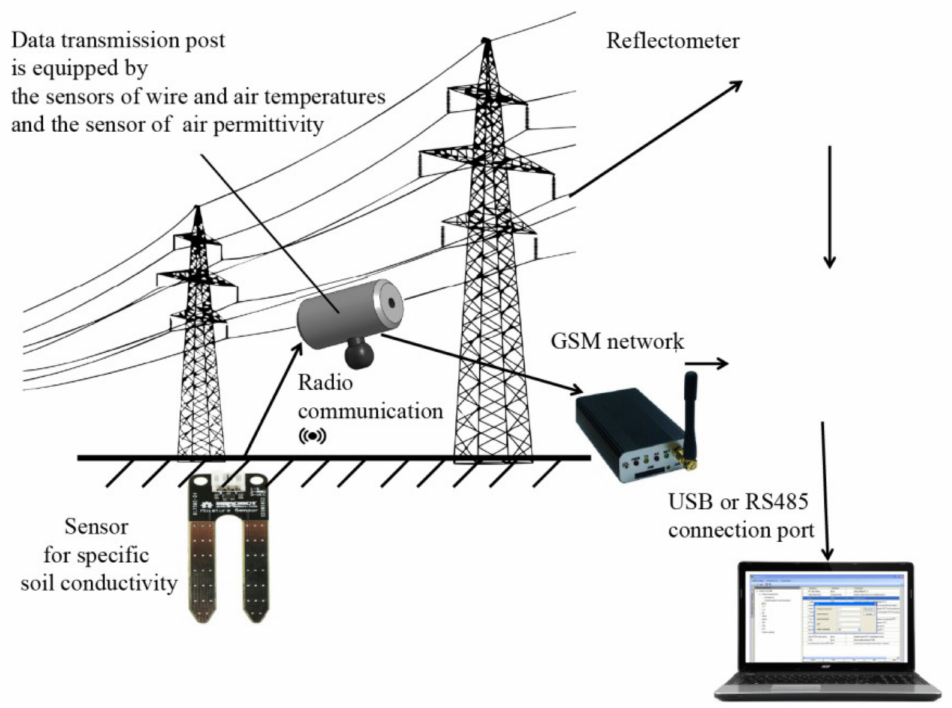
Figure 18. Principal scheme of an intelligent system of distance relay protection with adaptive algorithms for determine setpoints of the overhead power transmission